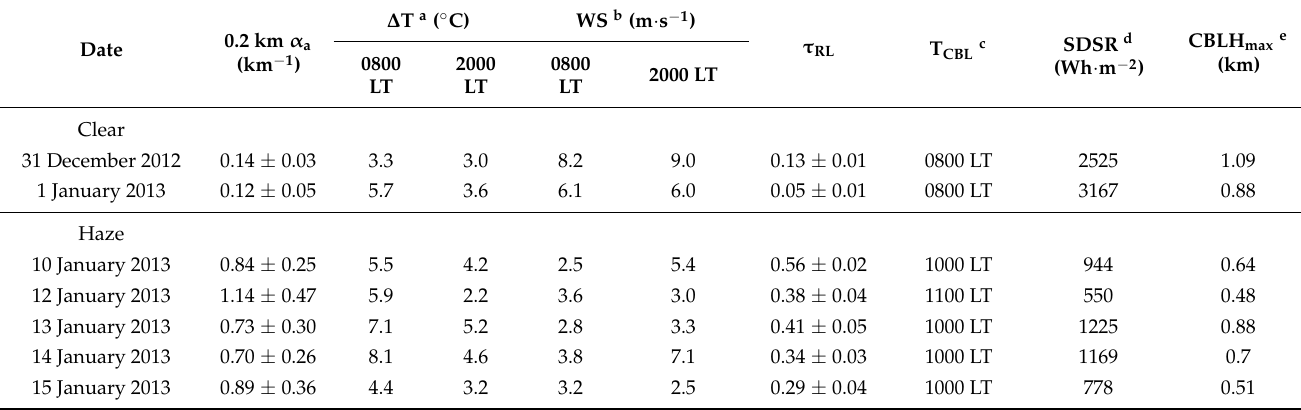
Figure 8. Profiles of ( a , o ) temperature (solid black line, bottom axis) and relative humidity (black dashed line, top axis), and ( b , p ) wind speed (solid black line, bottom axis) and wind direction (black dashed line, top axis) from the radiosonde measurements at ( a , b ) 0800 LT and ( o , p ) 2000 LT, respectively, on 31 December 2012, which was a clear day. Hourly average profiles of α a (red lines, bottom axis) and δ a (blue lines, top axis) from 0800–2000 LT on the same day are plotted in panels ( c – n ) with the convective boundary layer heights being marked as the horizontal dashed lines. The red and blue shades in panels ( c – n ) represent the standard deviations of α a and δ a , respectively. Table 2. Statistics of boundary-layer meteorological conditions and aerosol vertical extent during the observation period.